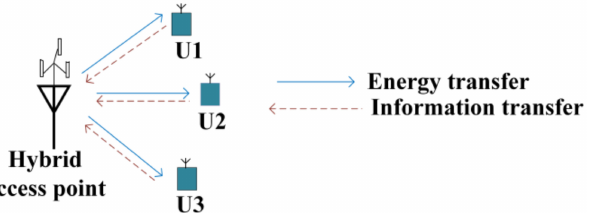
Figure 7. Wirelessly powered communication network with energy transfer and wireless informa- tion